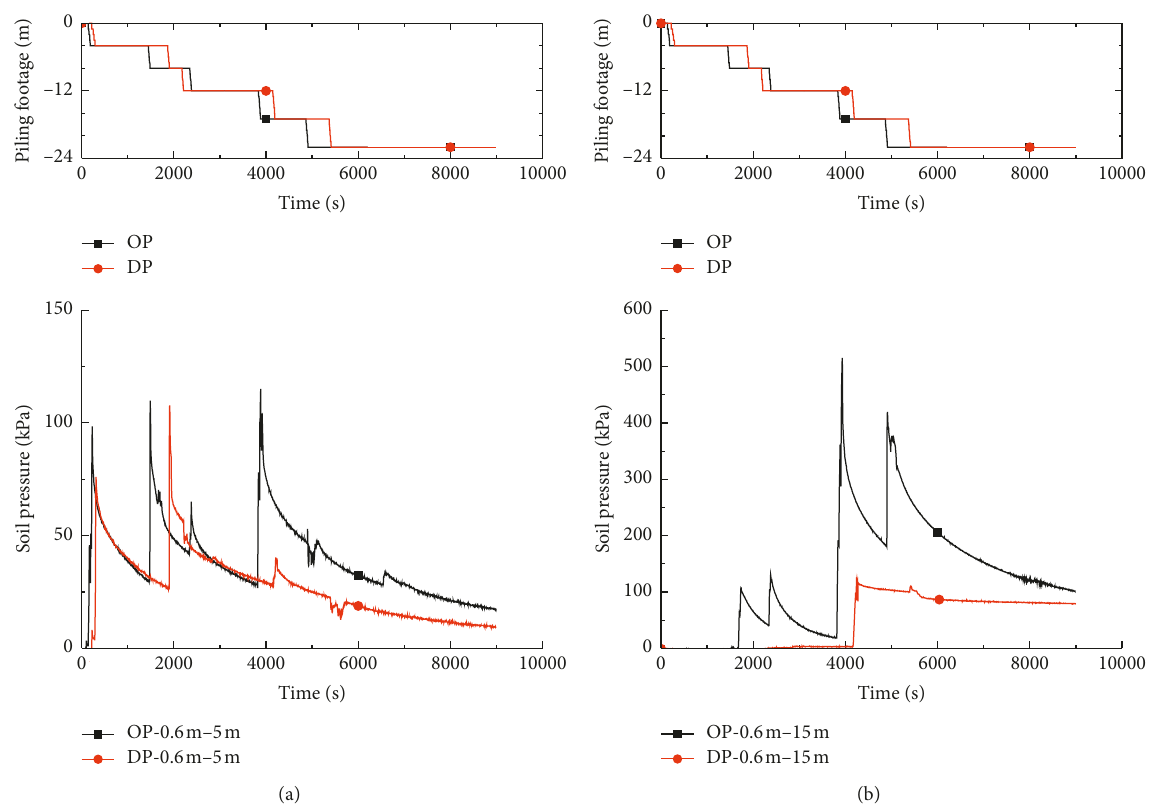
Figure 8: Dynamic horizontal soil pressure histories at measuring point 0.6m from the pile center in the entire process. (a) At 5m depth. (b) At 15m